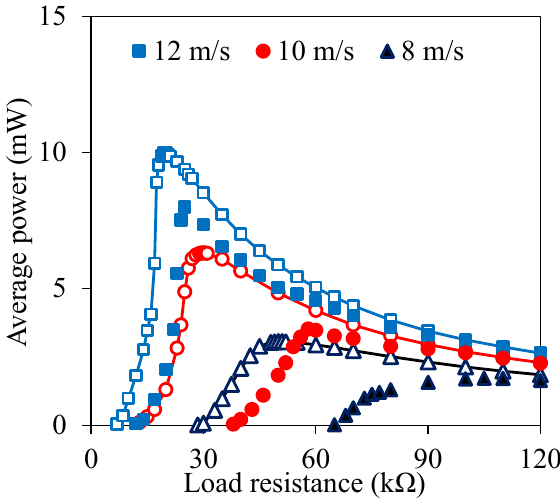
Figure 13. Variation of the average (RMS) power with the external load resistance for different wind velocities (solid symbols: measured; lines with empty symbols: simulated).